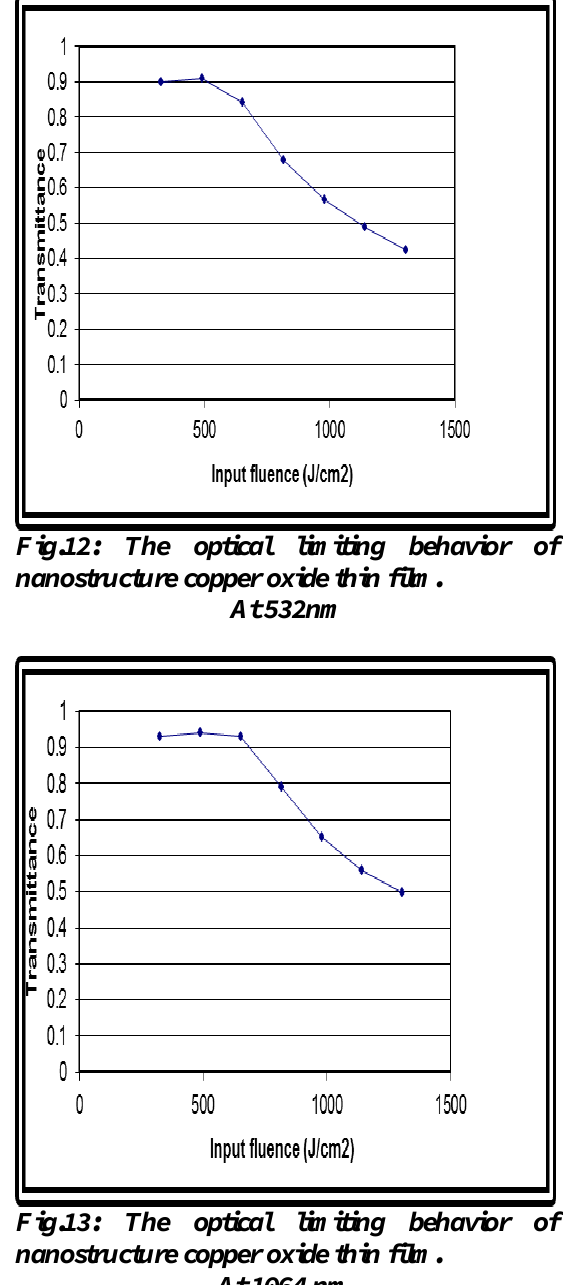
Fig.13: The optical limiting behavior of nanostructure copper oxide thin film. At 1064